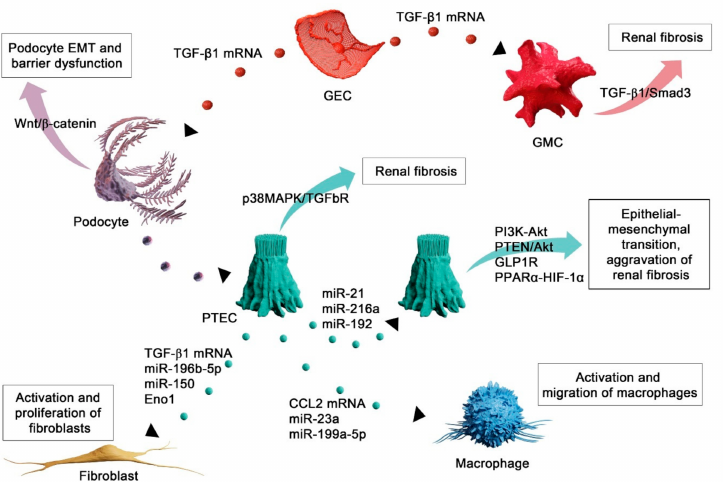
Figure 2. EV-mediated crosstalk between various renal cellular compartments during renal fibrosis. Injured renal proximal tubular epithelial cells (PTECs) can release and transfer EVs carrying different cargo to neighboring PTECs promoting epithelial–mesenchymal transition (EMT) and progression of renal fibrosis via different signaling pathways. Of note, injured podocytes can also transfer EV cargo to PTECs, inducing a strong pro-fibrotic response in these cells. Furthermore, EVs derived from injured PTECs participate in the process of fibroblast and macrophage cell activation, shuttling different cargo molecules into the recipient cell. Injured GECs shuttle their EVs containing TGF- β 1 mRNA to podocytes, mediating EMT and barrier dysfunction, as well as activation of GMCs. PTEC, proximal tubular epithelial cell; GEC, glomerular endothelial cell; GMC, glomerular mesangial cell. It has been demonstrated that crosstalk between podocytes and renal tubular cells has an important role in the development of renal fibrosis. Indeed, exposure of tubular epithelial cells to microparticles (MPs) isolated from cultured media of untreated differ- entiated human podocytes led to a significant pro-fibrotic response [81]. Podocyte MPs increased p38 and Smad3 phosphorylation and expression of the ECM proteins fibronectin and collagen type IV in cultured PTECs. Antagonism of cell surface scavenger receptor CD36 abrogated all podocyte MP-induced responses in PTECs [81]. Wu et al. 2017 [82] pointed to intercellular crosstalk between cells of the glomerulus as an essential step in the pathogenesis of renal fibrosis. Namely, the authors demonstrated that glomerular endothe- lial cells (GECs) treated with high glucose (HG) underwent endothelial–mesenchymal transition (EndoMT) and secreted exosomes enriched with TGF- β 1 mRNA. After being internalized by podocytes, GEC-derived exosomes mediated EMT and barrier dysfunction through the Wnt/ β -catenin signaling pathway. The authors proposed a role for paracrine communication via exosomes as important for the progression of renal fibrosis in diabetic nephropathy. The same group also demonstrated that exosomes containing TGF- β 1 mRNA released by HG-treated GECs could activate mesangial cells in the glomerulus to promote renal fibrosis through the activation of TGF- β 1/Smad3 signaling pathway